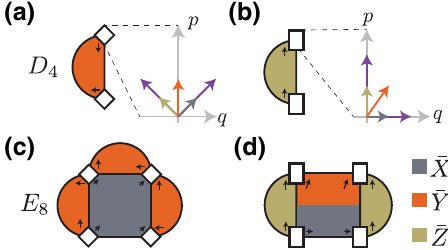
FIG. 12. Correspondence between some multimode lattices and concatenated codes. Multimode stabilizers are represented by both a color coding, with reference on the bottom right of the figure, and by small black arrows. The diamonds and rectangles represent single-mode GKP code, with a phase-space represen- tation of these modes shown in (a),(b). (a) The D 4 lattice code is equivalent to a diamond code concatenated with a two-qubit repetition code. (b) The tesseract code is equivalent to the con- catenation of a rectangular code with a two-qubit repetition code along ¯ Z . (c) The E 8 lattice is equivalent to a stabilizer state with a base diamond code. (d) Two tesseract codes can be concatenated along the ¯ Y axis to form a four-mode code with equal length logical Pauli